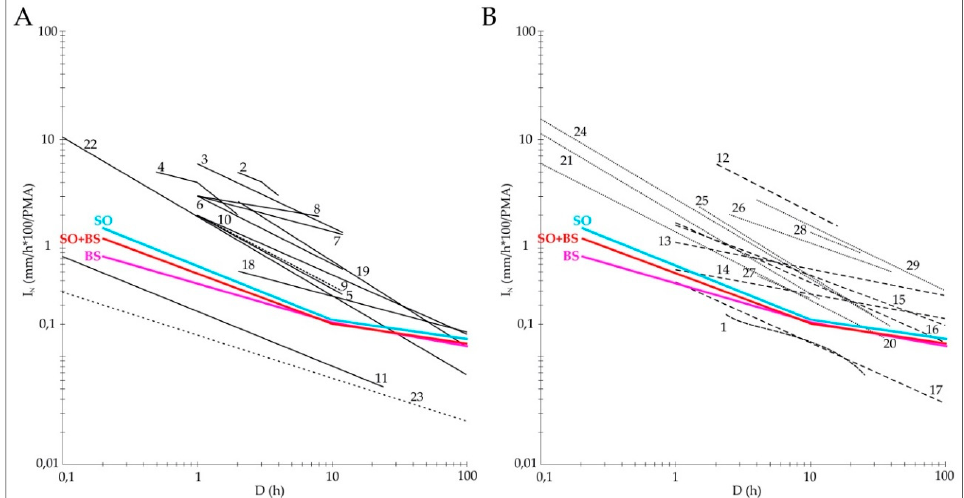
Figure 14. Comparison between the rainfall thresholds defined for Central- and South-Eastern Alps sectors of the Lombardy Region (SO + BS, red curve) and the Sondrio (SO, sky-blue curve) and Brescia (BS, fuchsia curve) Provinces and I N D curves available in literature for similar mountain areas in Italy and worldwide (Table 3): global (broken black curves) and regional (continuous black curves) ( A ) and local (broken black curves) or at single catchment scale (dotted black curves) ( B ). Table 3. MAP-normalized rainfall intensity IMAP (h − 1 )–rainfall duration D (h) thresholds for the initiation of shallow landslides and mud-debris flows in alpine or mountain regions in Italy and